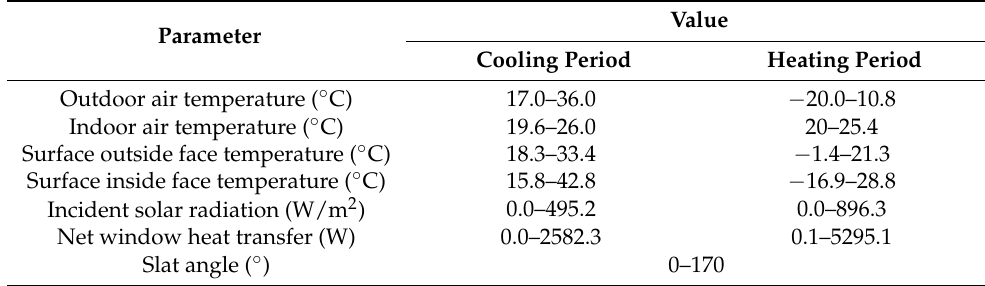
Table 5. Dataset parameters and value ranges.